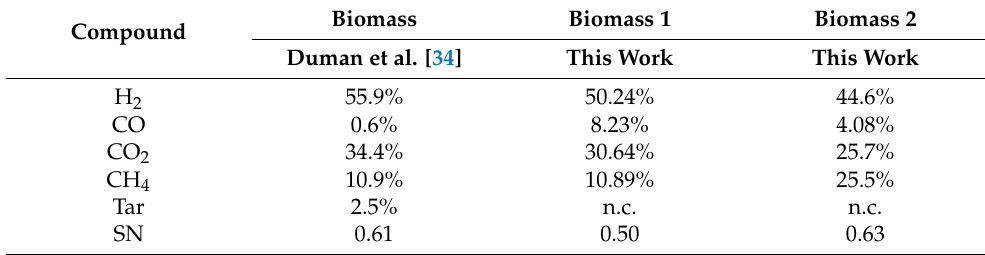
Table 6. Gas composition (%vol., dry basis) of this